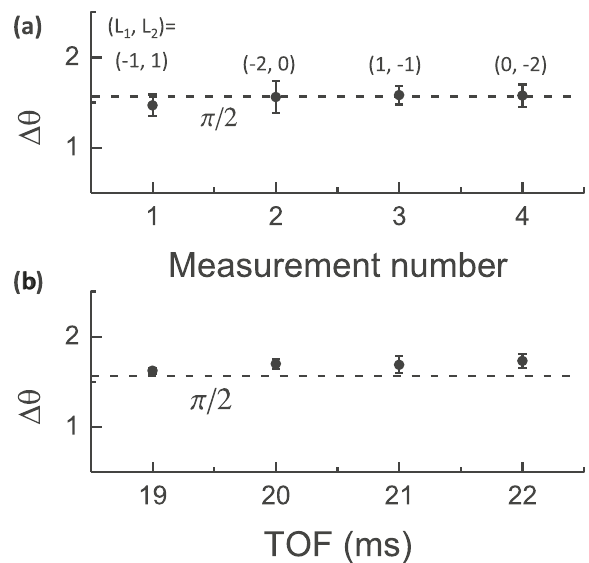
Fig. 5 Out-of-phase relation for different constituents of the Raman pulse and during the expansion of the condensate. a Δ θ for different constituents of the Raman pulse, i.e., ( L 1 = − 1, L 2 = 1), ( L 1 = − 2, L 2 = 0), ( L 1 = 1, L 2 = − 1), and ( L 1 = 0, L 2 = − 2). ∣ Δ l ∣ = 2 and TOF = 20 ms. b Δ θ for different TOFs, i.e., TOF = 19 ms, 20 ms, 21 ms, 22 ms. L 1 = − 2 and L 2 = 0. The dashed line denotes the value of π /2. The error bar is the standard deviation of six